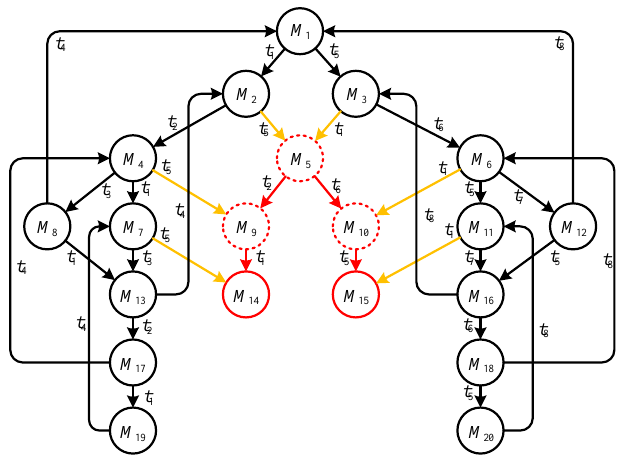
Figure 2. A Petri net model of flexible manufacturing systems (FMS).